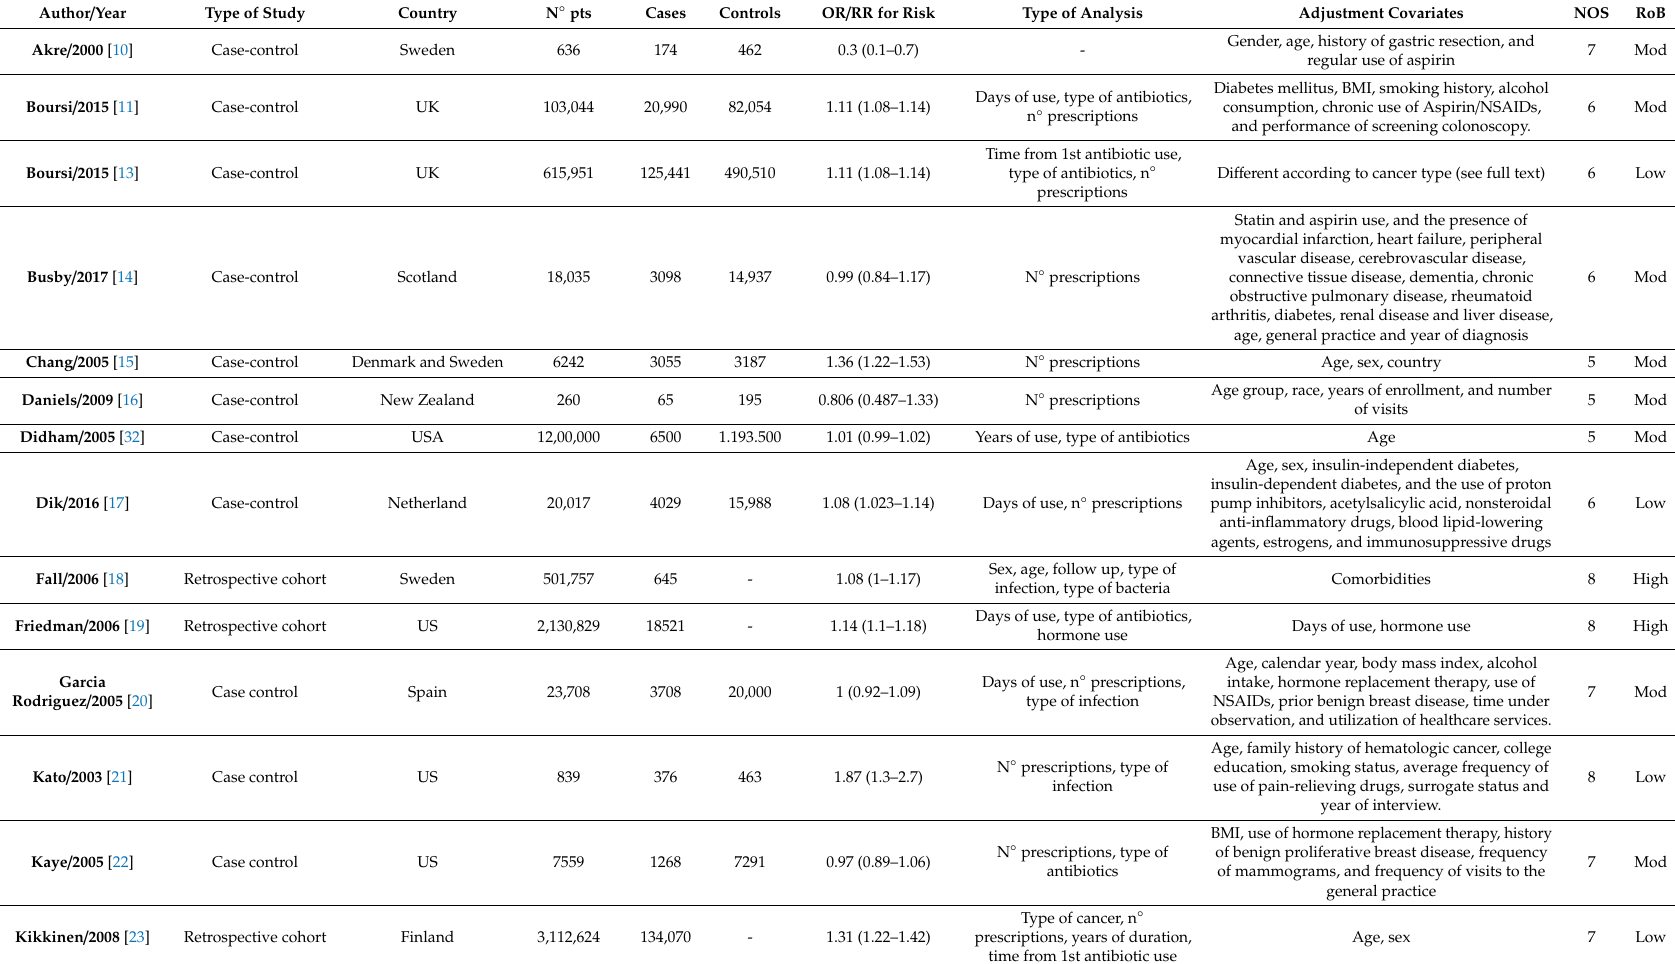
Table 1. Characteristics of the included